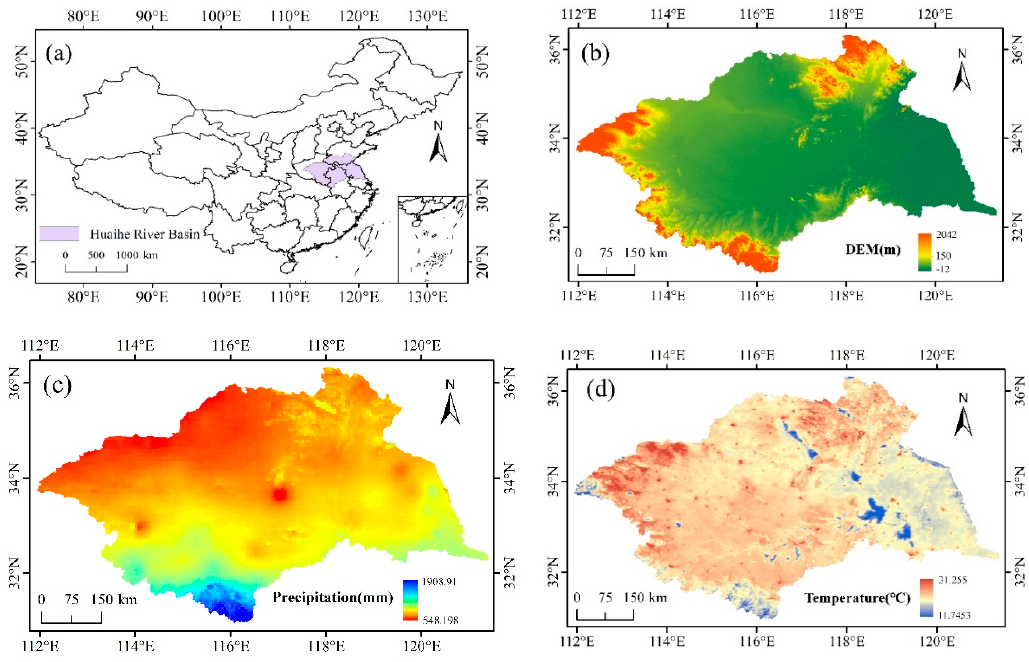
Figure 1. ( a ) Geographical location of the Huai River Basin; ( b ) Digital elevation model (DEM); ( c ) Average precipitation from 1989 to 2017; ( d ) Average temperature from 1989 to 2017.